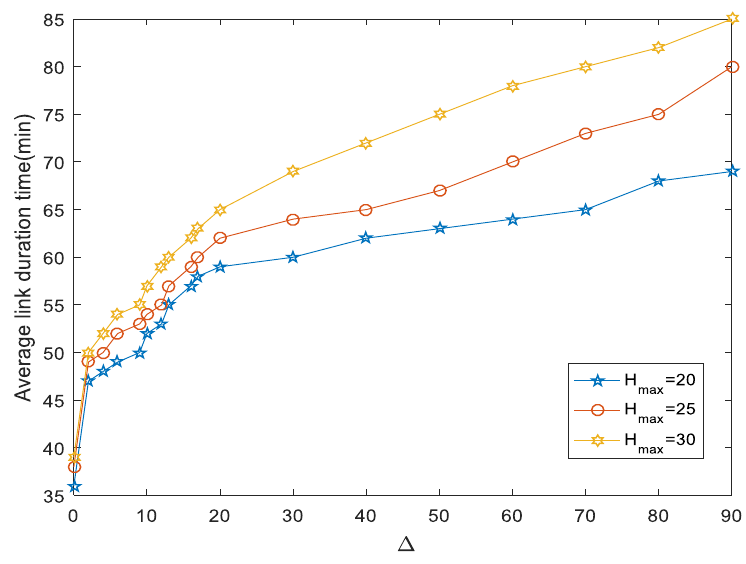
Figure 6. Average link duration time.